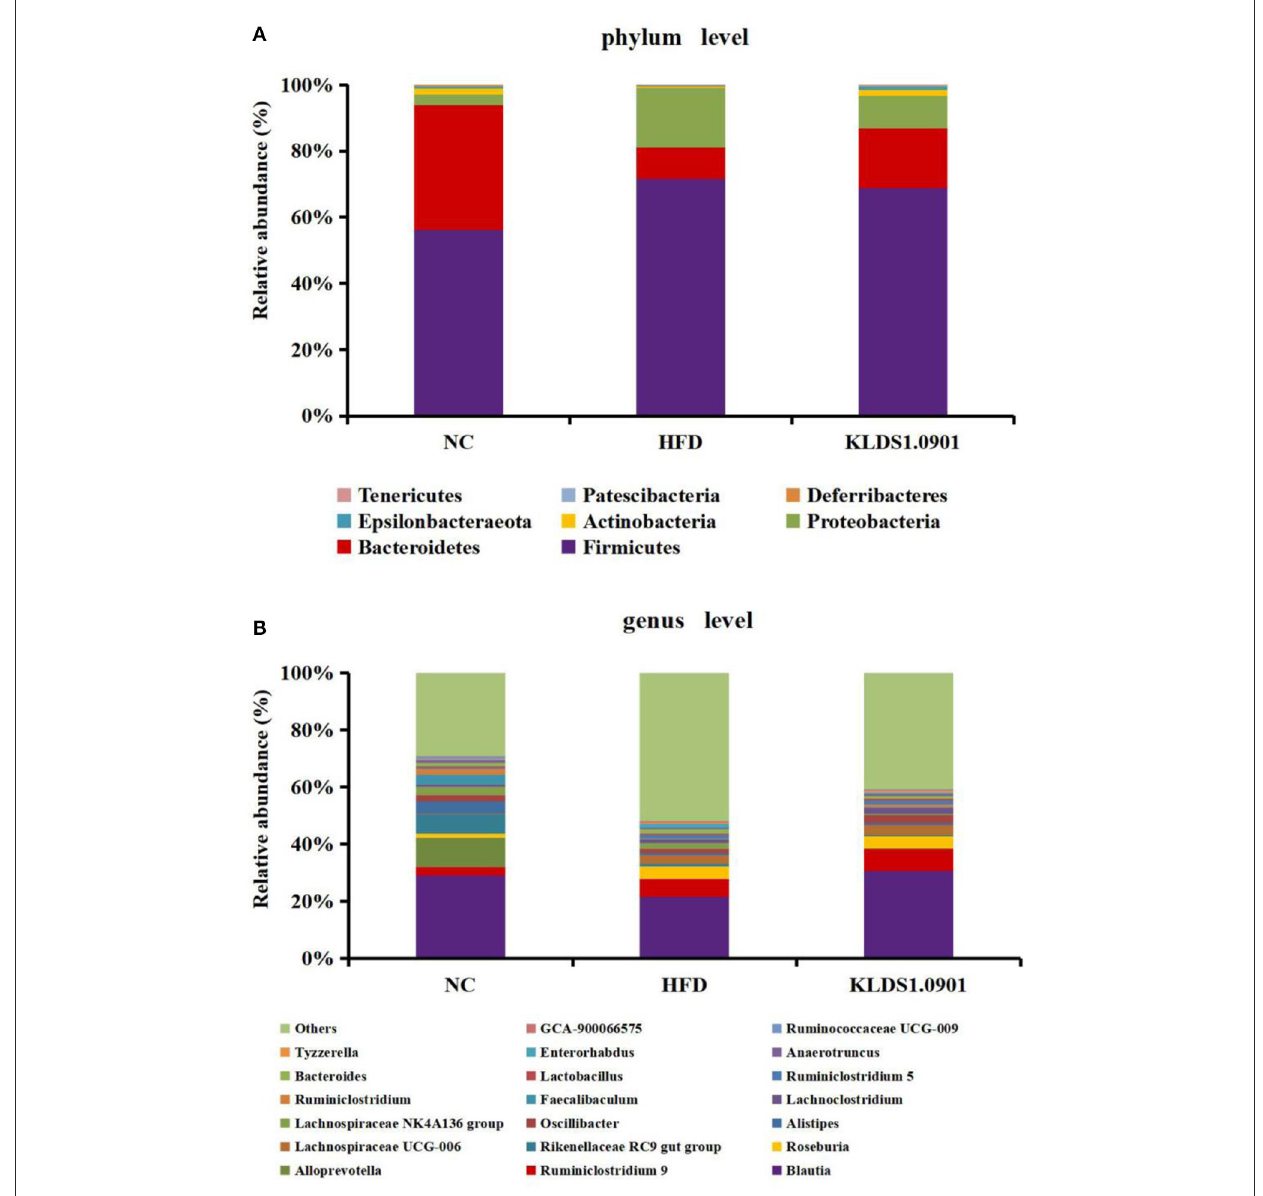
FIGURE8 Changes of the gut microbiota at the phylum (A) and genus (B) level after L. acidophilus KLDS1.0901 administration. NC, normal control group; HFD, high-fat diet group; and KLDS1.0901, L. acidophilus KLDS1.0901